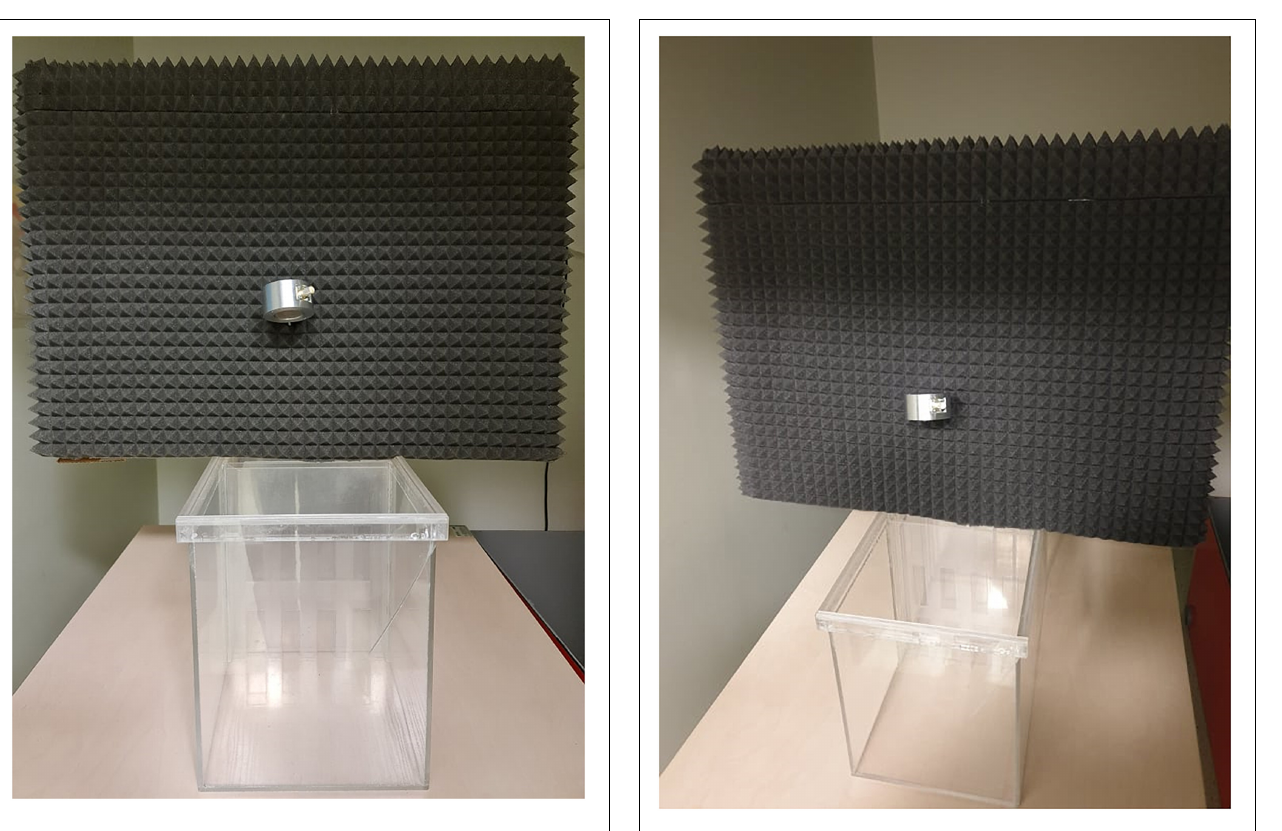
FIGURE 5 | The photograph of the VOC-NCE located in the behavioral recording room (the oblique view). For clarity, cables have been unplugged from the microphones, and the covering grid was